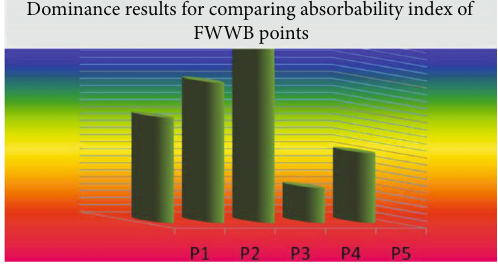
Figure 3: Dominance theory application for evaluating absorbability index of respective FWWB points vs. FsCS, shown by bar chart.